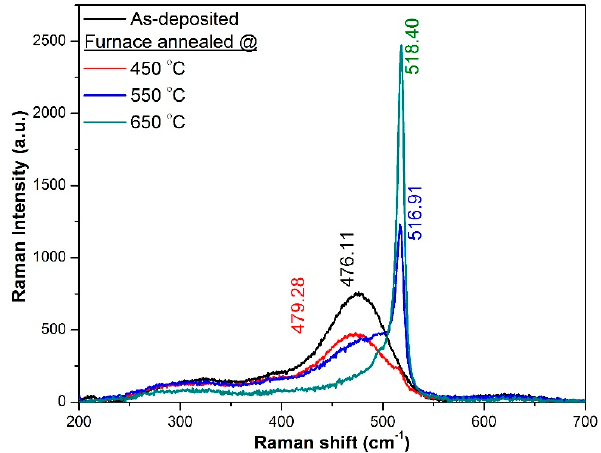
Figure 8. Raman spectra of furnace annealed PECVD silicon thin films at different temperatures.